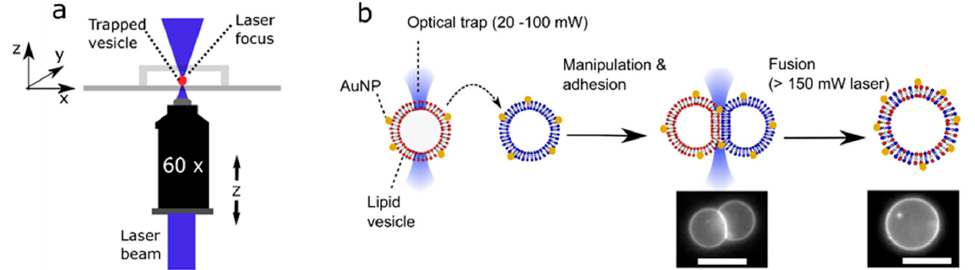
Figure 1. Schematic of the processes involved in laser-assisted vesicle adhesion and fusion. ( a )